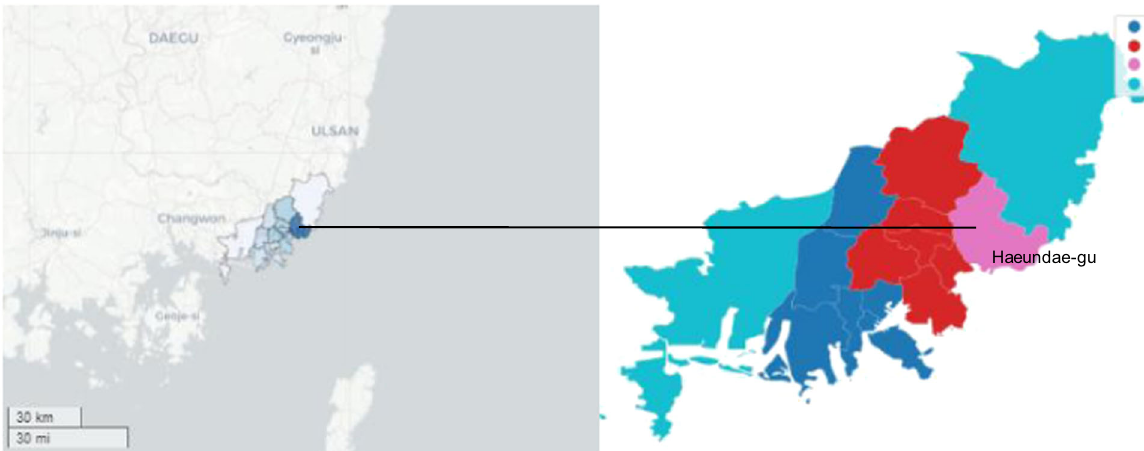
Fig. 9 Map visualization of clustering ( K = 4),